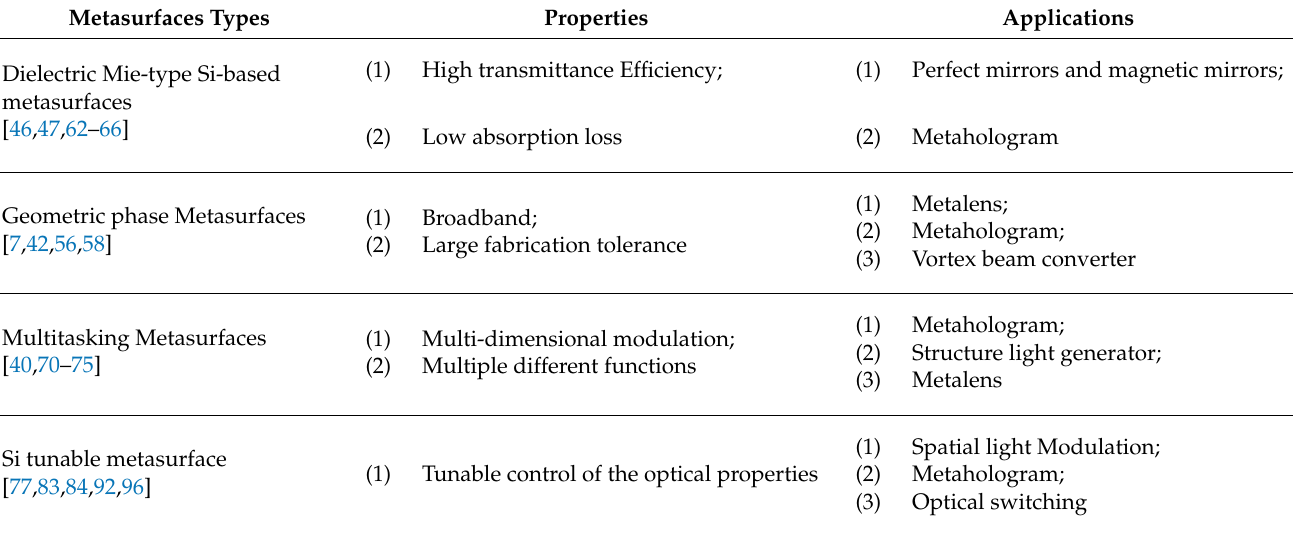
Table 1. Guidelines for several applications of different types of